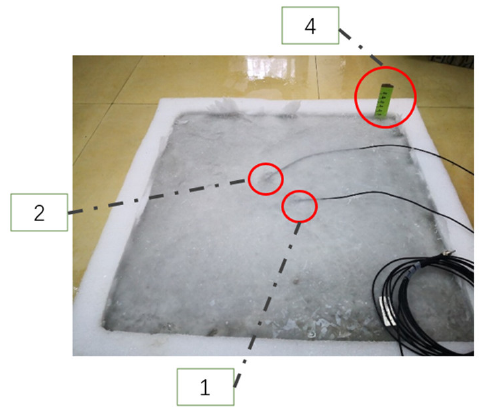
Figure 2. A concrete specimen covered with